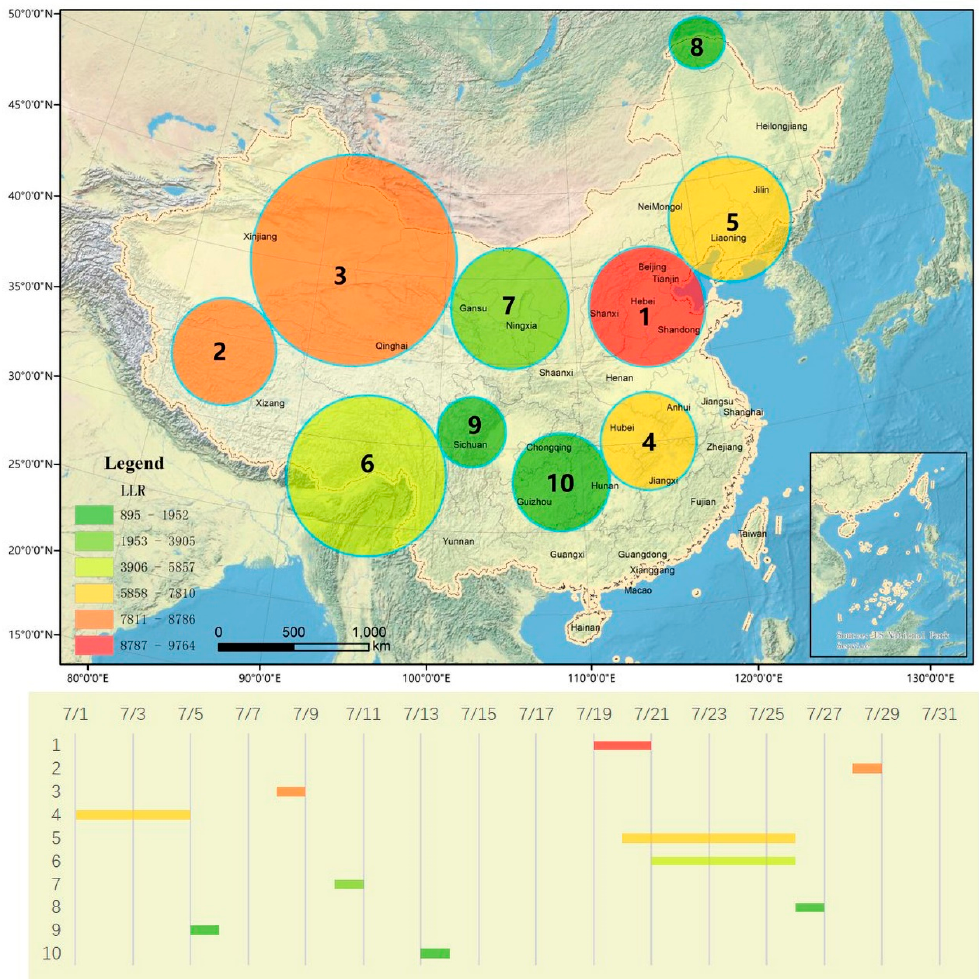
Figure 4. Spatio-temporal aggregation pattern of extreme precipitation events in July 2016, China.